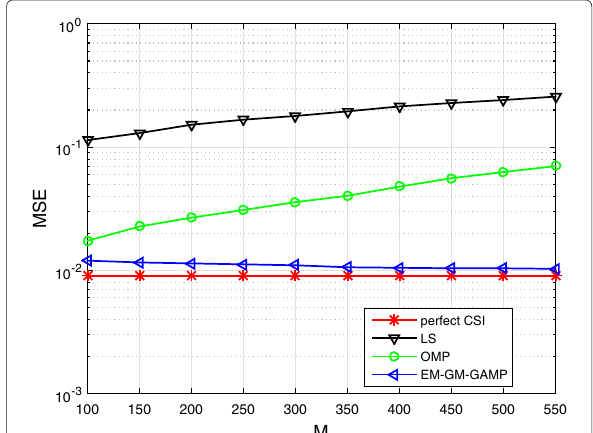
Fig. 3 MSE performance comparison of different algorithms as functions of M with SNR = 15 dB , L = 3, N